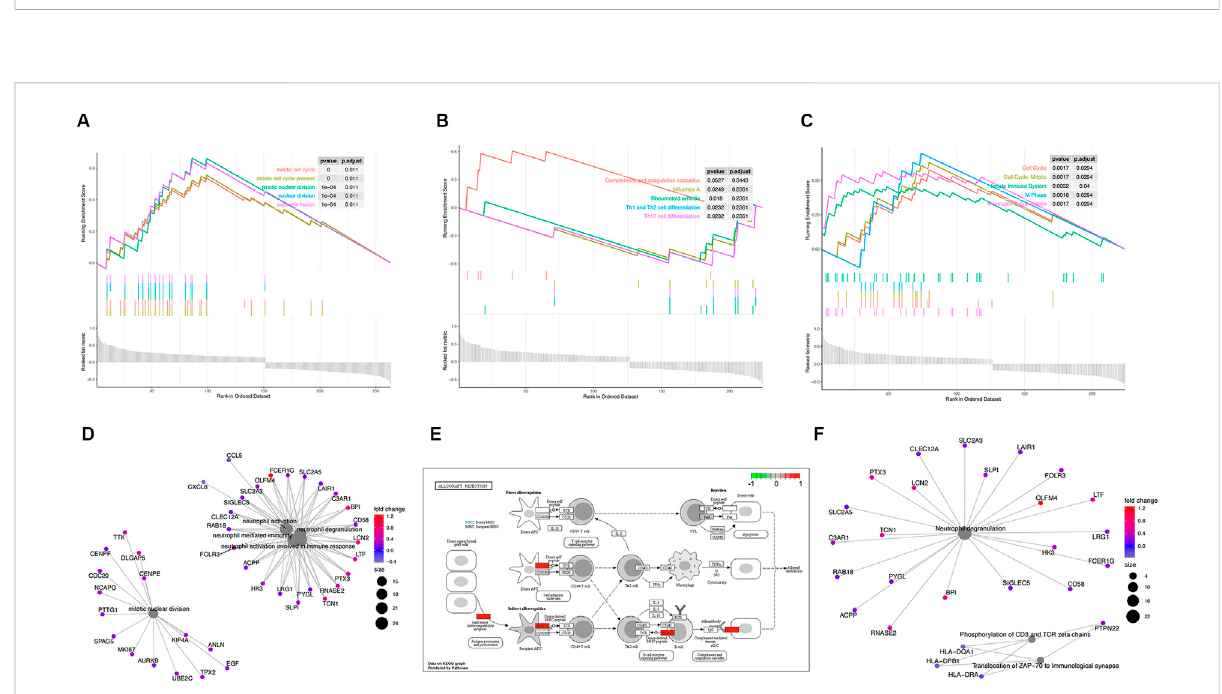
FIGURE 4 Functional enrichment analysis of GSE57065. (A) KEGG pathways enrichment analysis. (B) Gene ontology (GO) enrichment analysis. (C) Reactome enrichment analysis. (D) . emap visualizes gene ontology and gene-function relationships. (E) Signi fi cant enrichment pathways; green represents genes that have relatively low expression and red represents genes that have relatively high expression. (F) emap visualizes Reactome gene-function